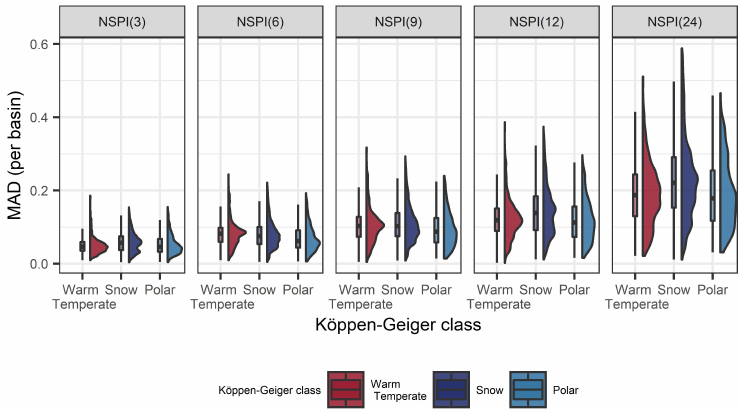
Figure 11. Distribution of the mean absolute deviation (MAD) between the NSPI computed on the training set only and the NSPI computed on the training, validation and test sets for different Köppen-Geiger climatic classes and 36,662 basins in Sweden during